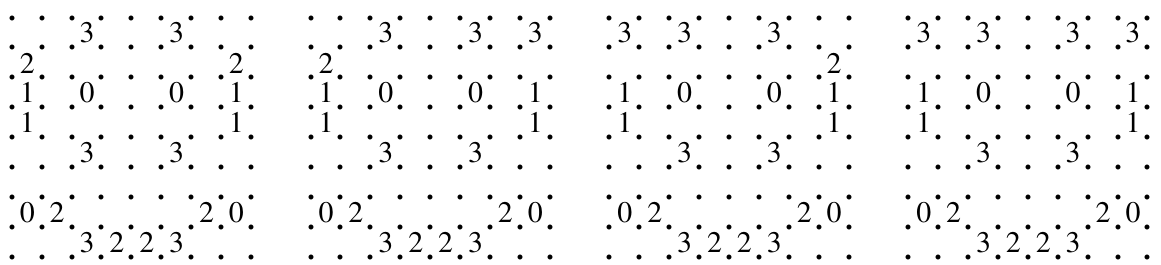
Figure 10. Output of Slitherlink generation; example #2.